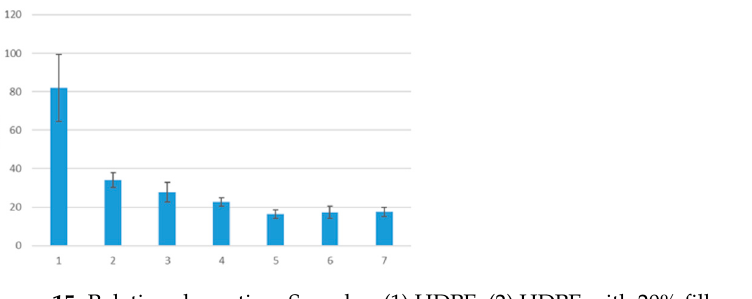
Figure 15. Relative elongation. Samples: (1) HDPE, (2) HDPE with 20% filler content, (3) HDPE with 40% filler content, (4) HDPE with 50% filler content, (5) HDPE with 60% filler content, (6) HDPE with filler content 70%, (7) HDPE with a filler content of 80%.